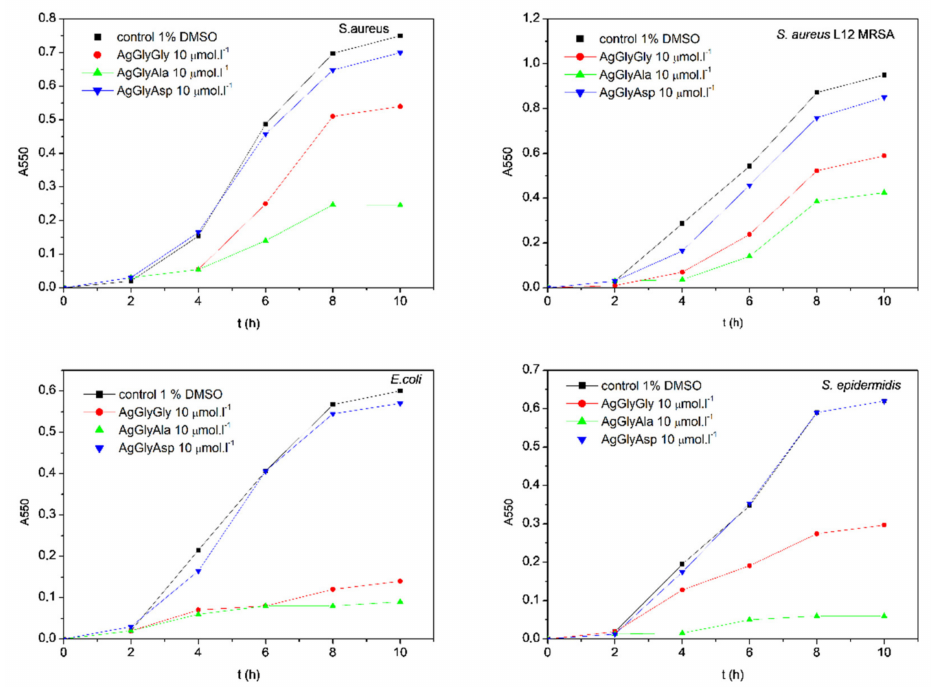
Figure 5. Growth of bacterial cells in the presence of silver(I) complex after addition to the lag phase.